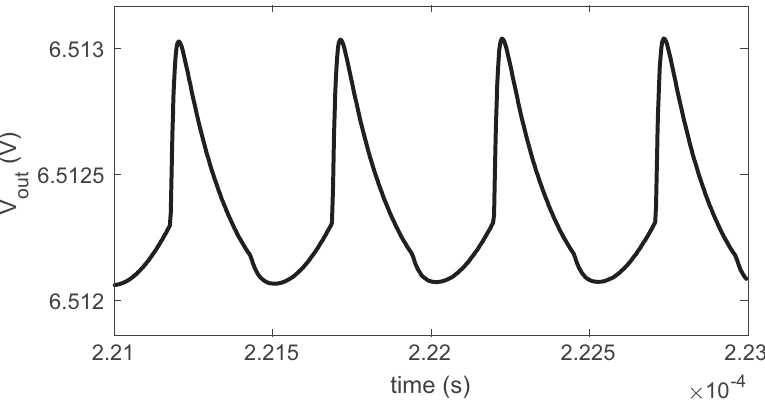
Figure 13. Simulated output ripple for 1 µ A load.